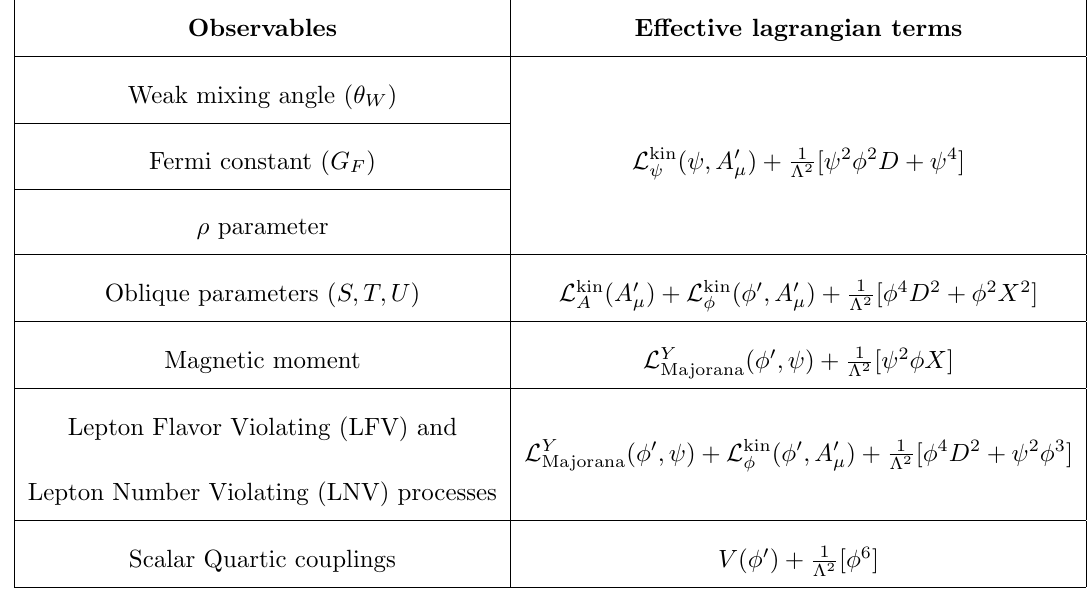
Table 26. Low energy observables and their origin in e(cid:11)ective